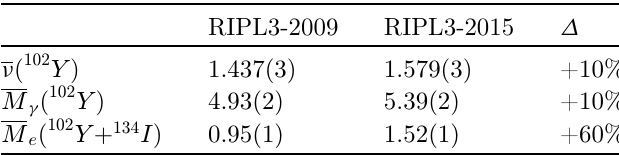
Table 2. In fl uence of S n on average multiplicities.